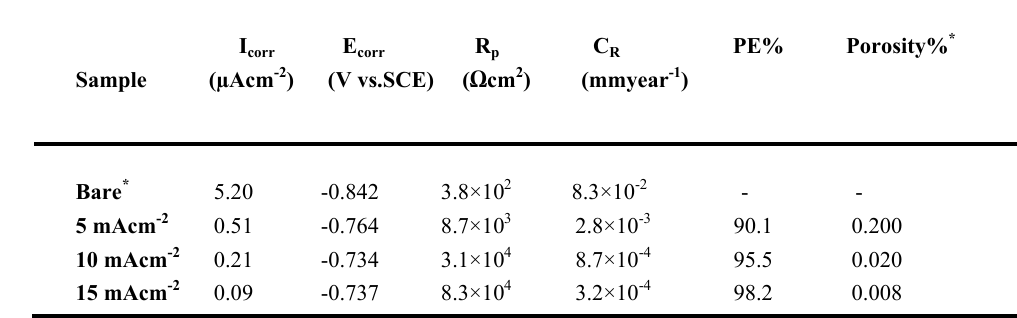
Table 2. Electrochemical parameters of electropolymerized polyaniline-TiO 3.5% NaCl solution under the galvanostatic conditions at different current densities.